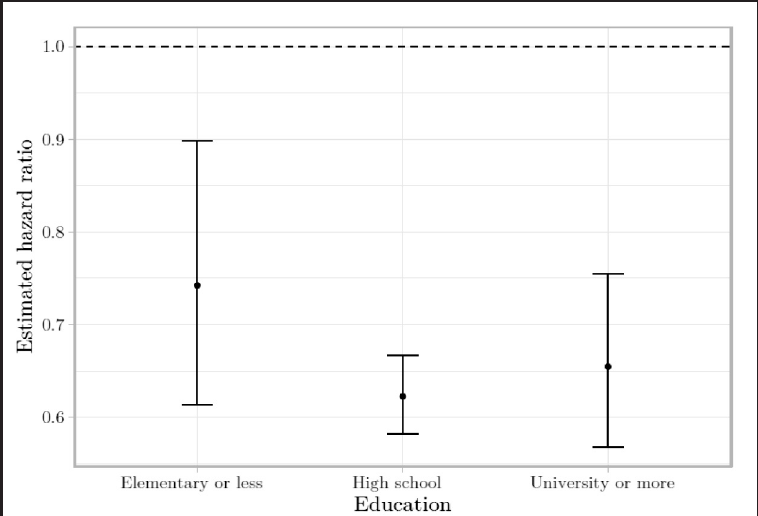
Heterogeneous effects: